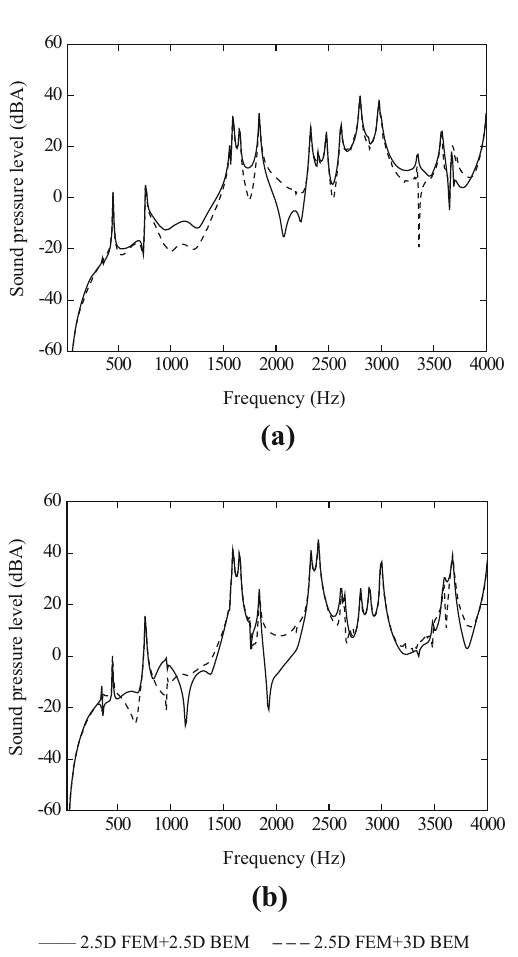
Fig. 8 Comparisons of the sound pressure levels at the standard measured points. a Standard measuring point A and b standard measuring point B